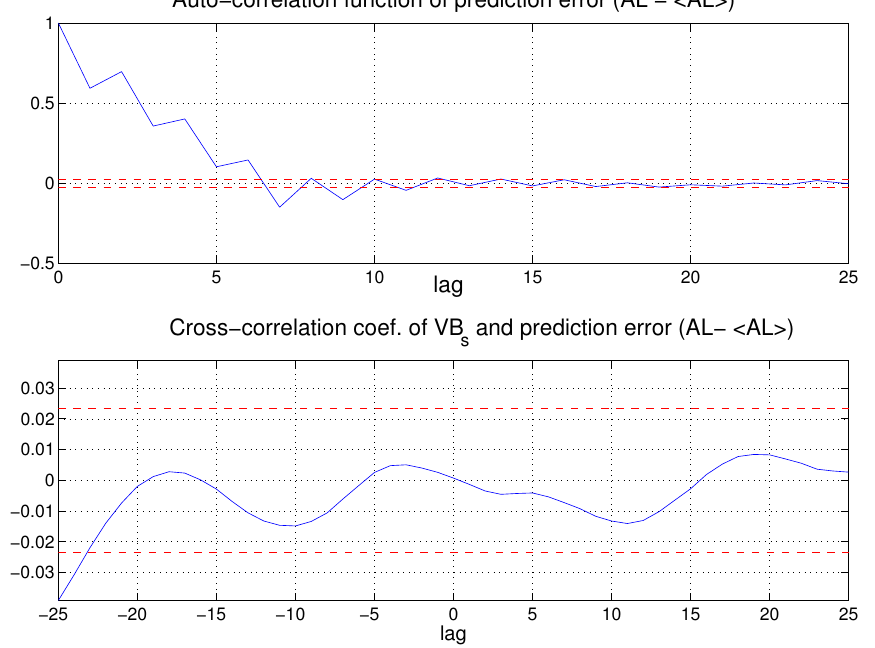
Fig. 2. Top panel: the autocorrelation function of the prediction error. Bottom panel: the cross correlation between the input ( V B s ) and the prediction error.